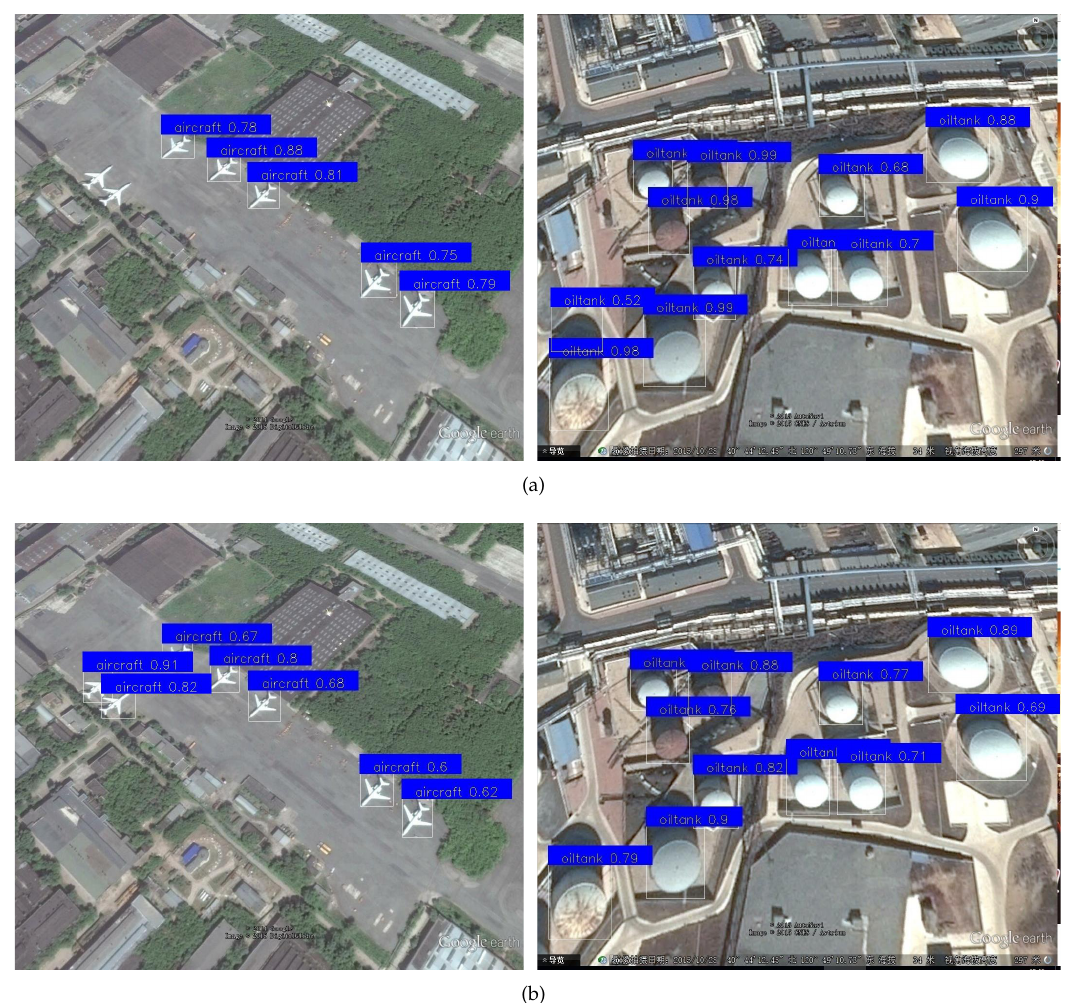
Figure 10. Comparison of object detection results between pre-trained network and pruned lightweight network on RSOD data set: ( a ) object detection results for the pre-trained network, and ( b ) object detection results for the pruned lightweight